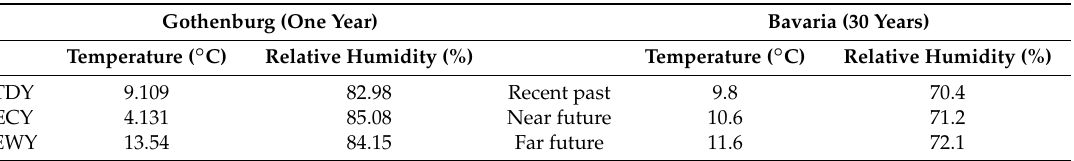
Table 2. Predicted yearly average outdoor T and RH in Gothenburg (affecting the generic buildings) and the 30 years average of Bavaria (affecting the Roggersdorf